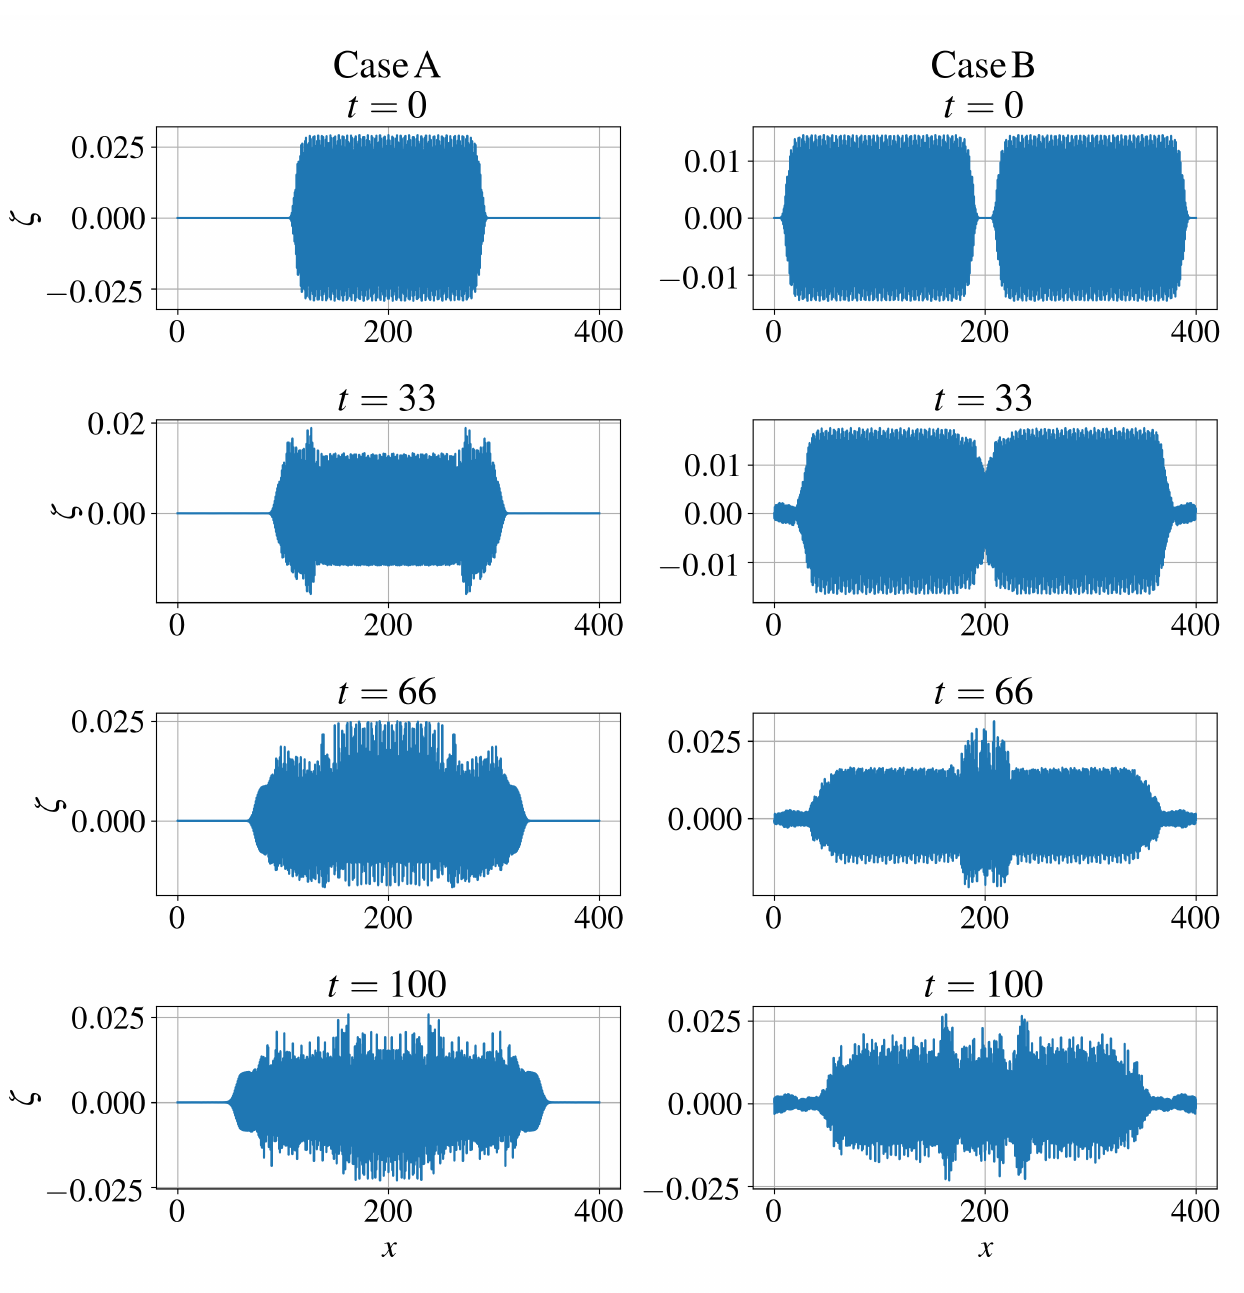
Figure 8. Snapshots of the surface elevation ζ ( x , t ) at various times the ‘A’ configuration ( left ) and the ‘B’ configuration ( right ) of initial coincident wave packets given in Equations (24)–(28). The numerical ‘probes’ are located at x = 198 and x = 202 to be 2 m either side of the domain centre, in-keeping with the experiments of Section 4